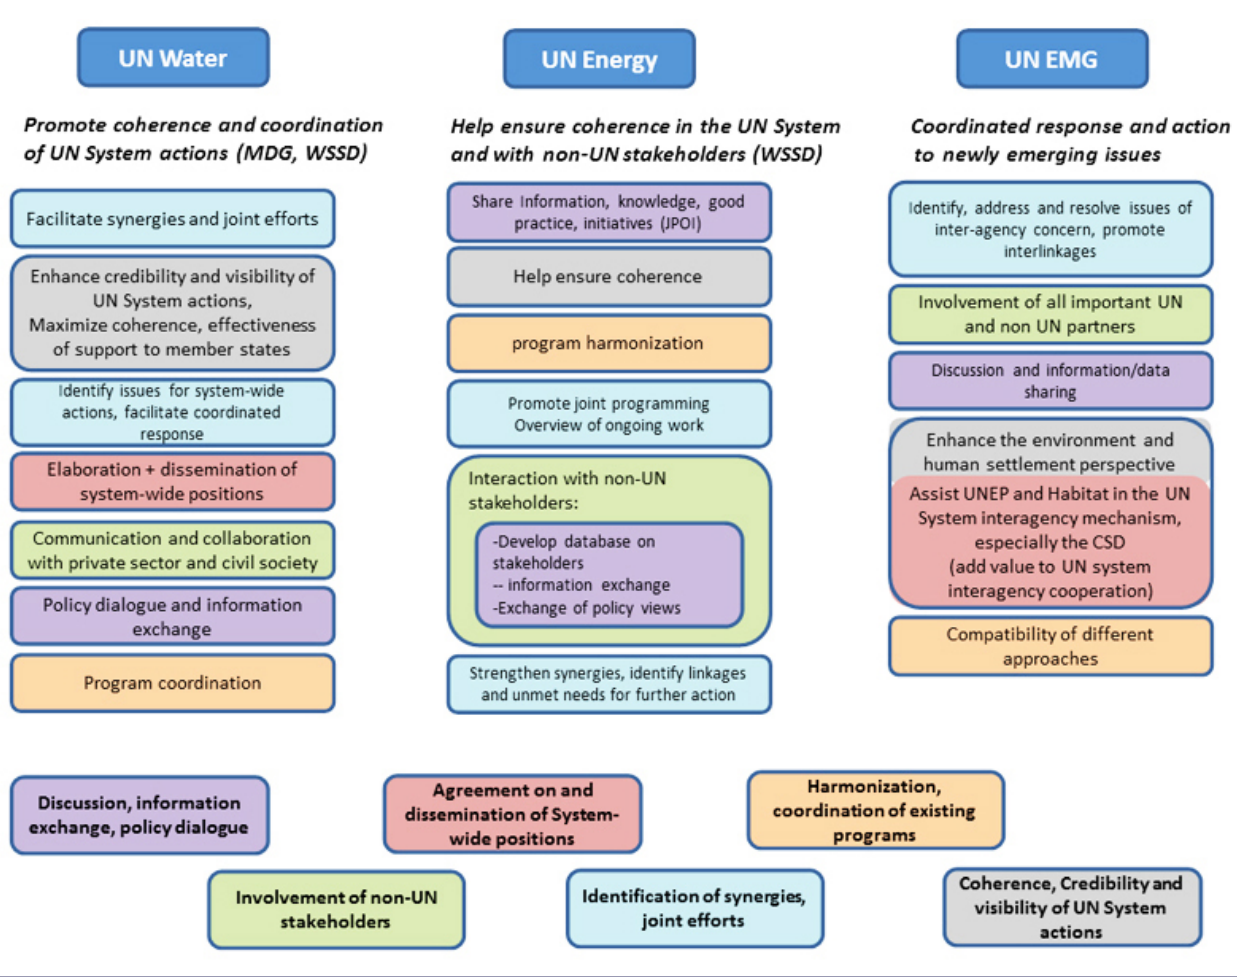
Fig. 2 . Comparative mandates of UN-Water, UN-Energy, and UN Environment Management Group (UN